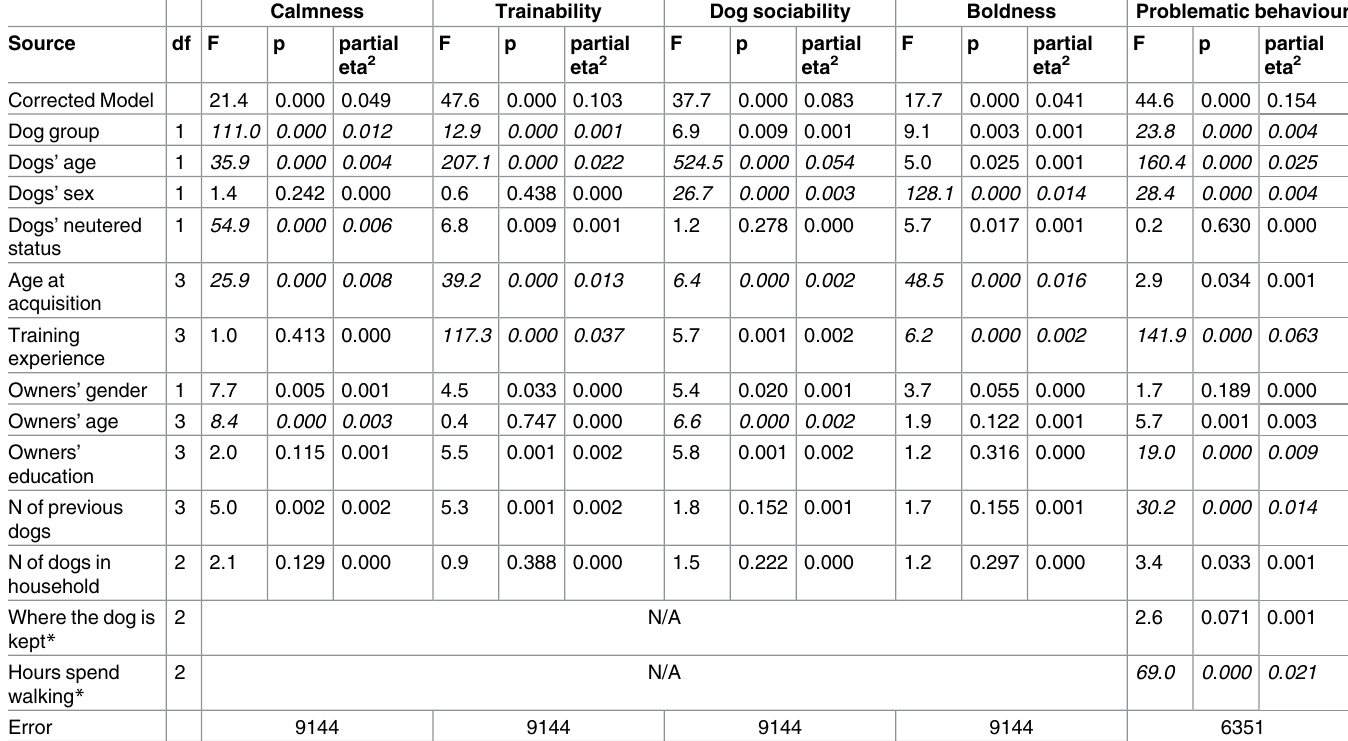
Table 3. Relationship between the demographic and dog keeping factors and the behaviour traits investigated with GLMs.